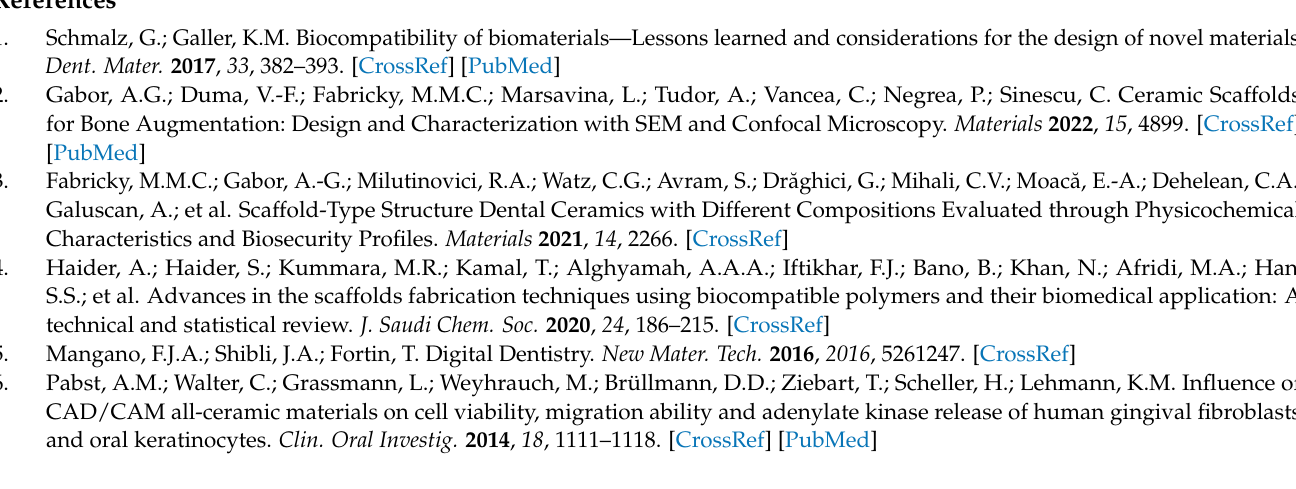
of BJ human cells. Table S2: Mitochondrial activity percentage of HaCaT cells. Table S3: Cytotoxicity percentage of BJ cells. Table S4: Cytotoxicity percentage of HaCaT cells. Table S5: NO production of human BJ cells. Table S6: NO production of HaCaT